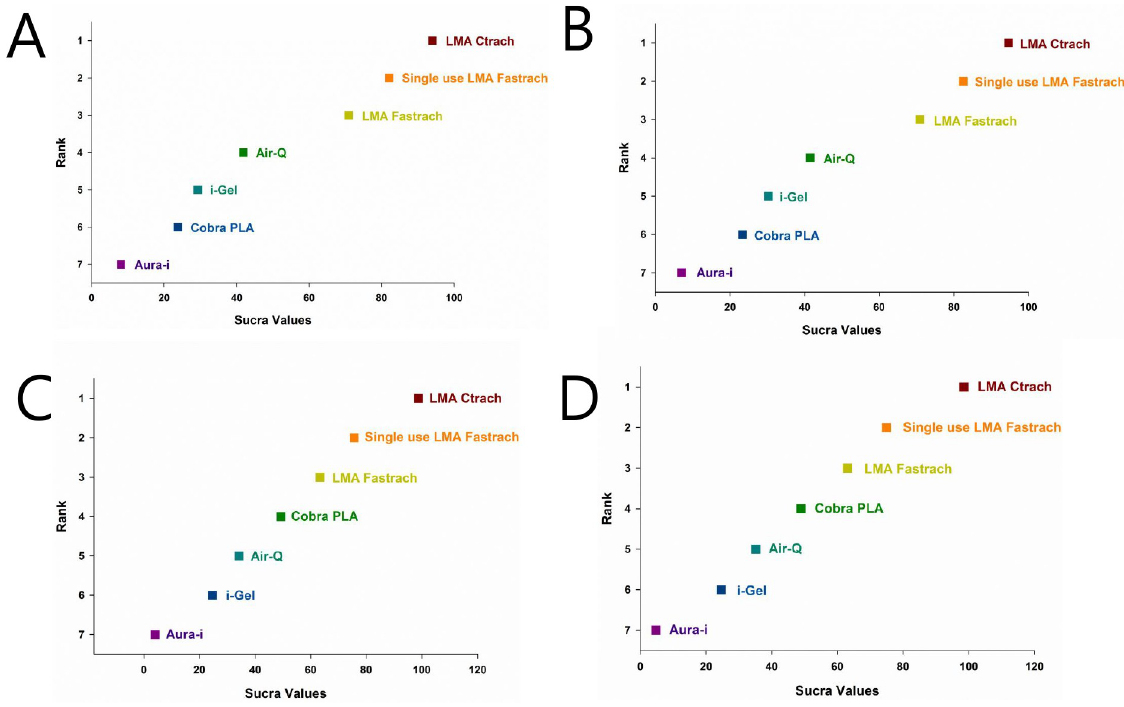
Fig 4. The expected ranking and SUCRA values of each airway device as a strategy for unassisted tracheal intubation. A. The overall success rate of unassisted tracheal intubation by ITT; B. The overall success rate of unassisted tracheal intubation by PP; C. The success rate at first attempt by ITT; D. The success rate at first attempt by PP. SUCRA, surface under the cumulative ranking curve; ITT, intention to treat; PP, per protocol.